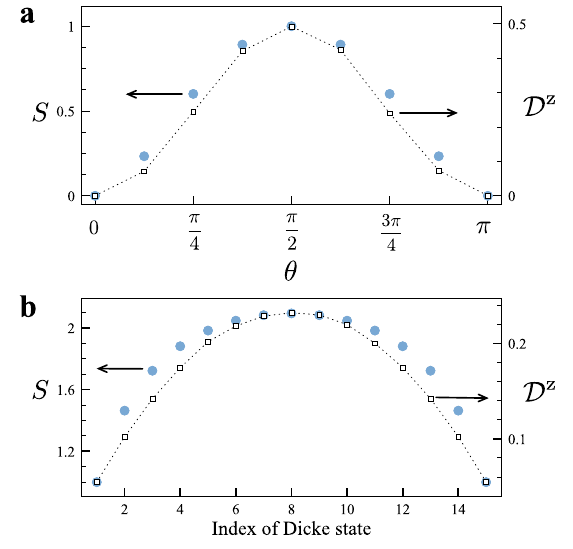
Fig. 4 Comparison of entanglement and dissimilarity. a Entanglement entropy S (blue circles) and overall dissimilarity D z (white squares) of the Schrödinger cat states as functions of angle θ . b The same characteristics of the Dicke states as functions of index D